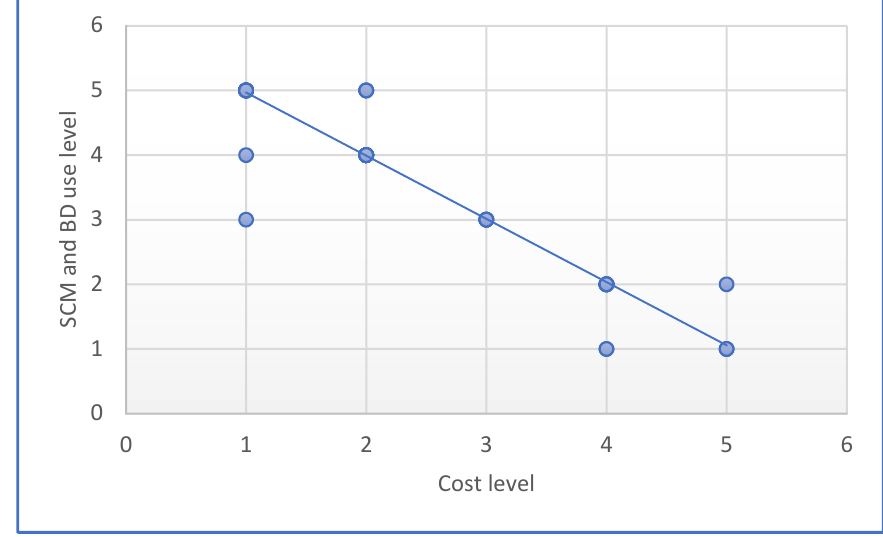
Figure 6. Relationship between SCM and BD use level and cost level. Appl. Sci. 2021 , 11 , x FOR PEER REVIEW